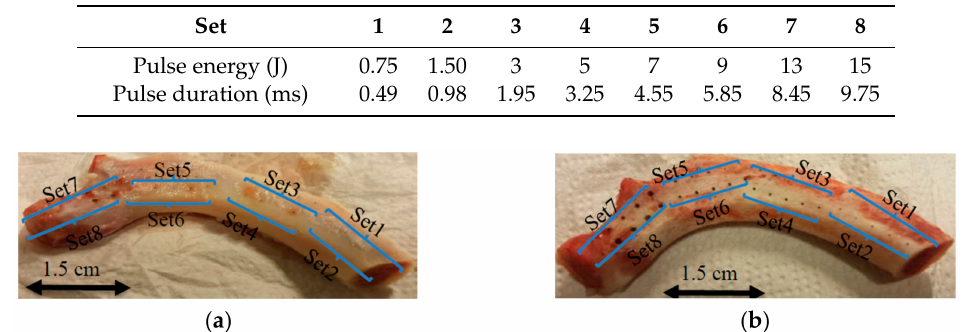
Figure 1. Ablated hard bone in ( a ) wet and ( b ) dry conditions at di ff erent pulse energies summarized in Table